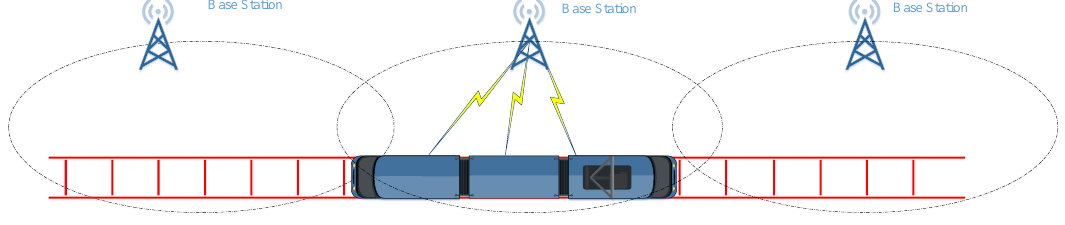
Figure 1. A diagram of HSR communication scenario.